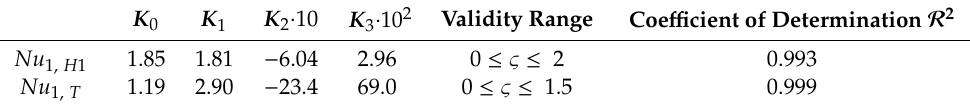
Table 2. Correlation factors for data from Shah et al. [44].